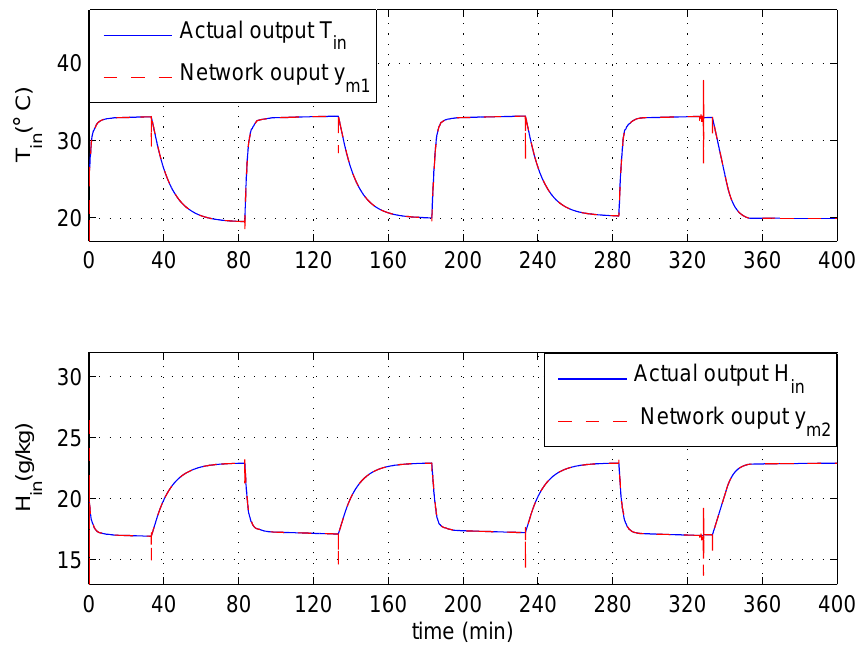
Figure 11. Temperature and humidity matching conditions between the actual output and RBF network model